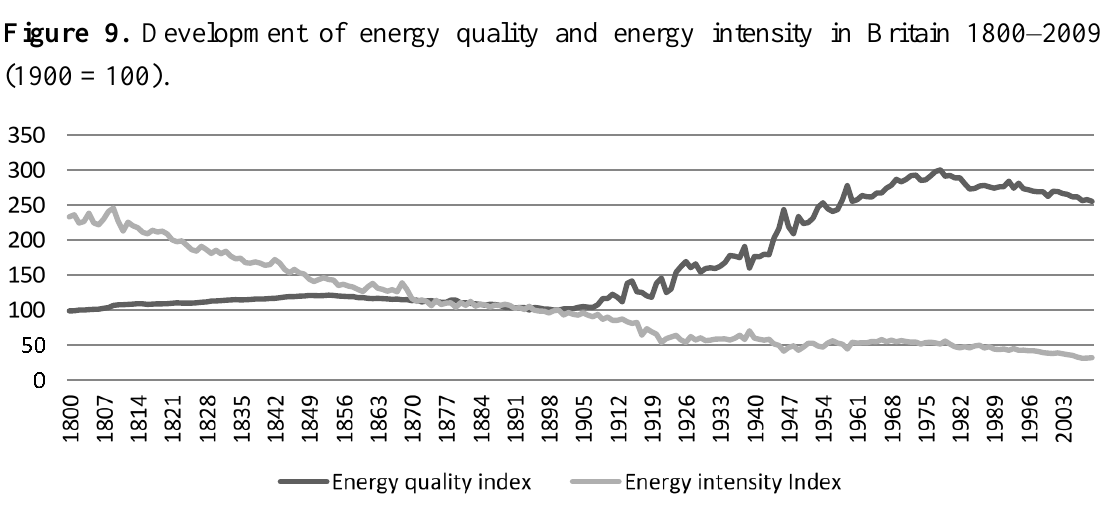
Figure 10. Development of energy quality and energy intensity in Sweden 1800–2009 (1900 =